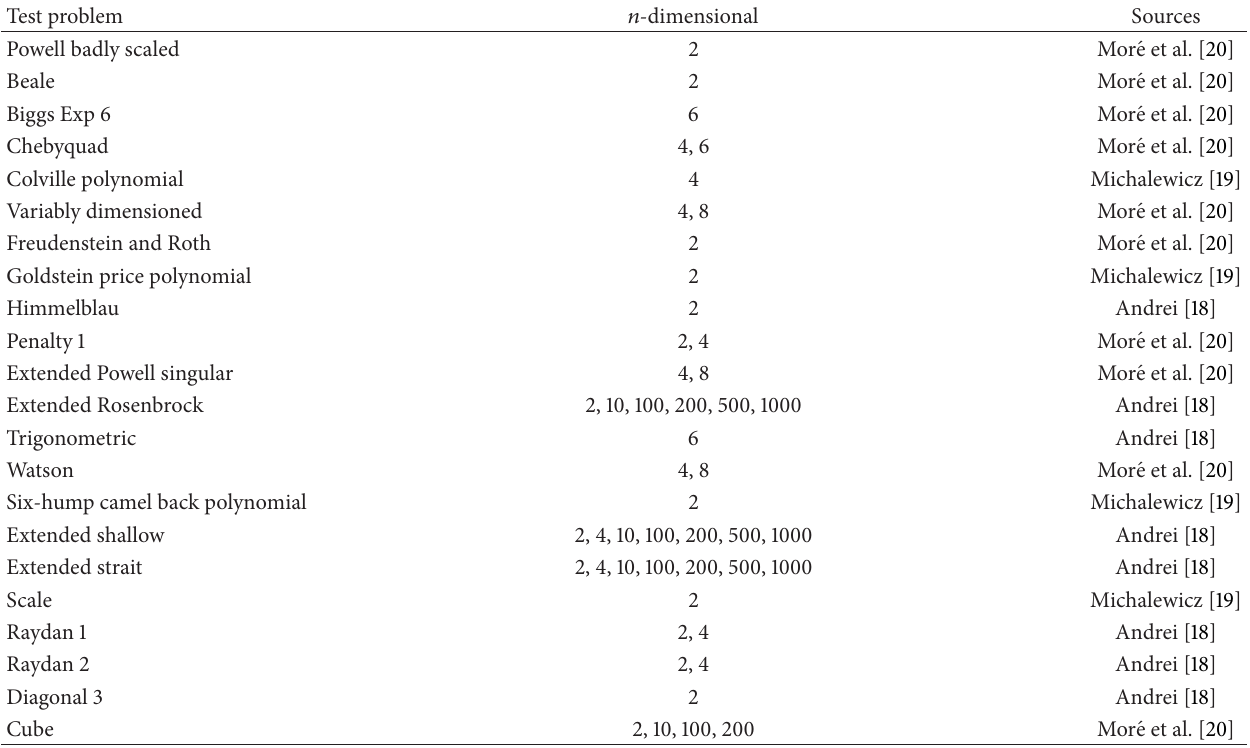
Table 1: A list of problem